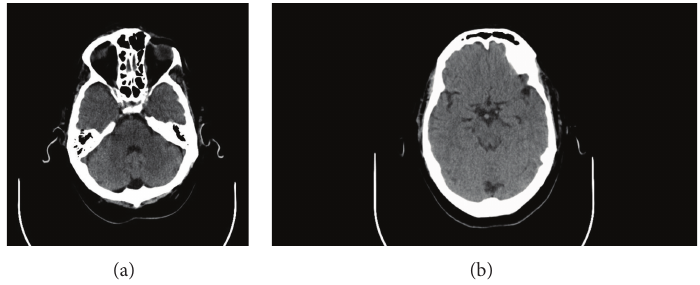
Figure 3: CT head scan on postoperative day 2 showed resolution of the